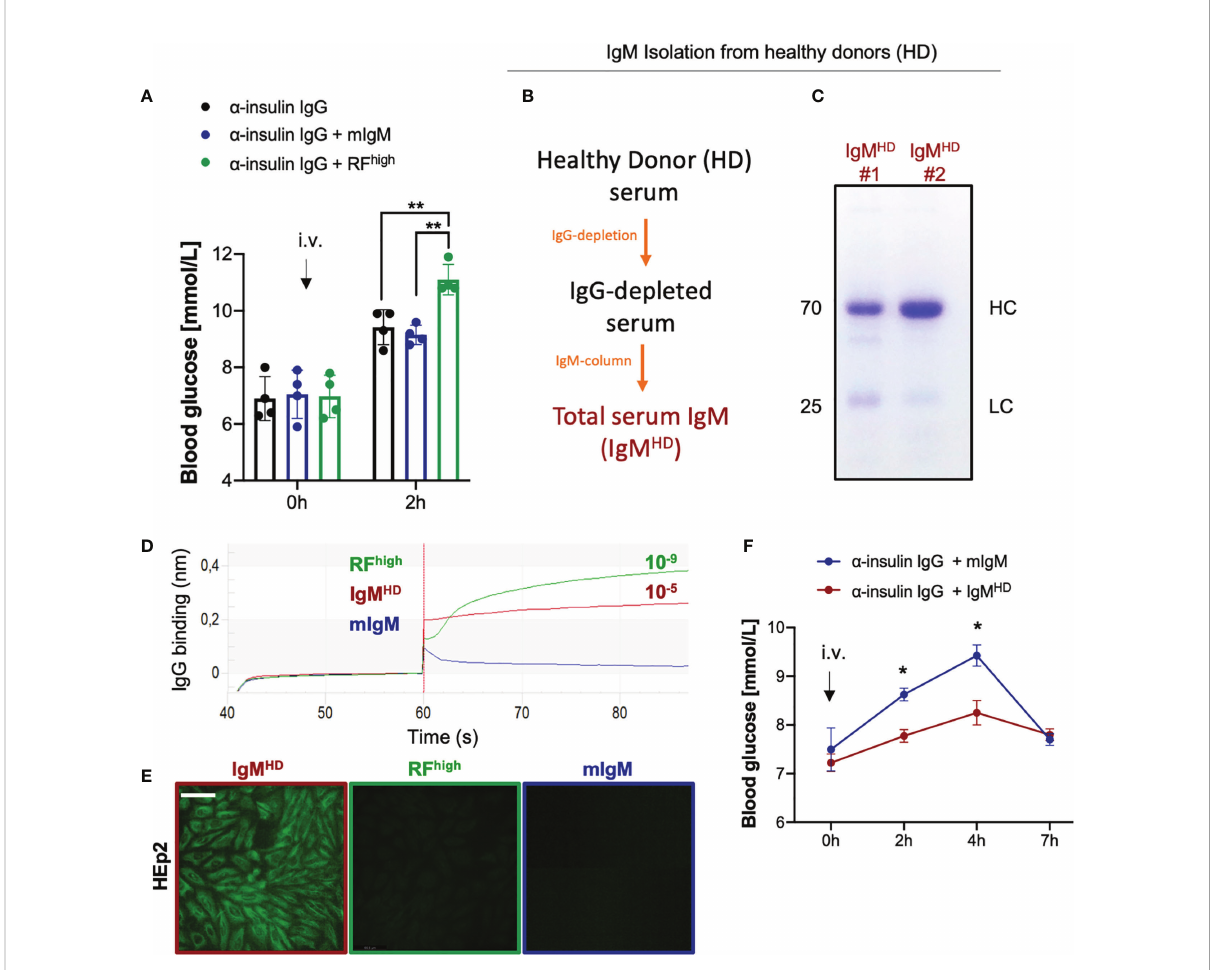
FIGURE 2 High af fi nity RF enhances the effect of autoreactive IgG. (A) Blood glucose concentrations of WT mice intravenously injected with 100 µg a - insulin IgG alone (black bar, n = 4) or in combination with 20 µg RF concentrate from rheumatoid arthritis patients (RF high, green bar, n = 4) or monoclonal IgM control (mIgM, blue bar, n = 4) measured at indicated time points. Mean ± SD, statistical signi fi cance was calculated using two- way ANOVA with Tukey ’ s multiple comparisons test. **p < 0,01. (B) Scheme depicting the procedure for isolation of total IgM from healthy donors (HD) sera. (C) Coomassie blue-stained SDS-PAGE showing total IgM isolation from n=2 healthy donors (IgM HD ) under reducing conditions (with b -mercaptoethanol). The image is representative of three independent experiments. (D) IgG-binding af fi nity of IgM isolated from healthy donors (IgM HD , dark red line), RF high (green line) and monoclonal IgM control (mIgM, blue line) measured by bio-layer interferometry. K D (dissociation constant) was calculated by the software. The experiment shown is representative of 3 independent experiments. (E) HEp-2 slides showing anti-nuclear structure-reactive IgM (ANA) for total IgM isolation (IgM HD, dark red square), RF high (green square) and monoclonal IgM control (mIgM, blue square). Scale bar 65 µm. Green fl uorescence indicates IgM binding to HEp-2 cells. Images are representative of three independent experiments. (F) Blood glucose concentrations of WT mice intravenously (i.v.) injected with 100 µg a -insulin IgG combination with 20 µg total IgM puri fi ed from healthy donors (dark red line, n = 4) or with monoclonal IgM control (blue line, n = 4) measured at indicated time points. Mean ± SD, statistical signi fi cance was calculated using two-way ANOVA with Sidak ’ s multiple comparisons test. *p <